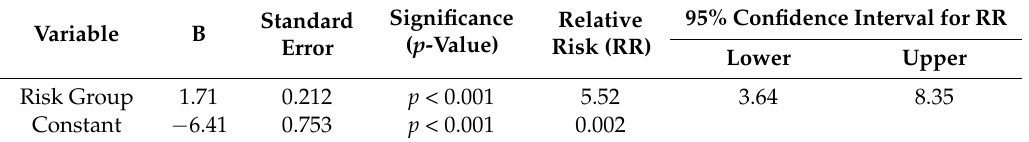
Table 3. Logistic regression model for the association between “risk group” and the incidence of peri-implant disease.